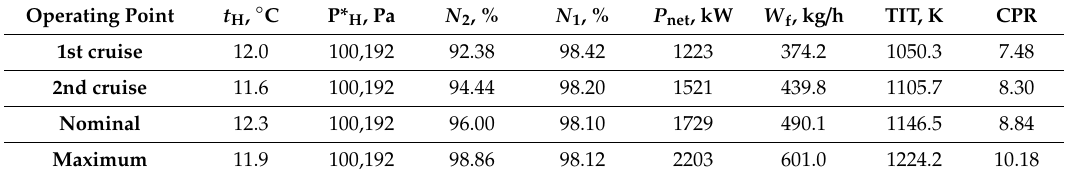
Table 4. Values of measured parameters determined by the corrected